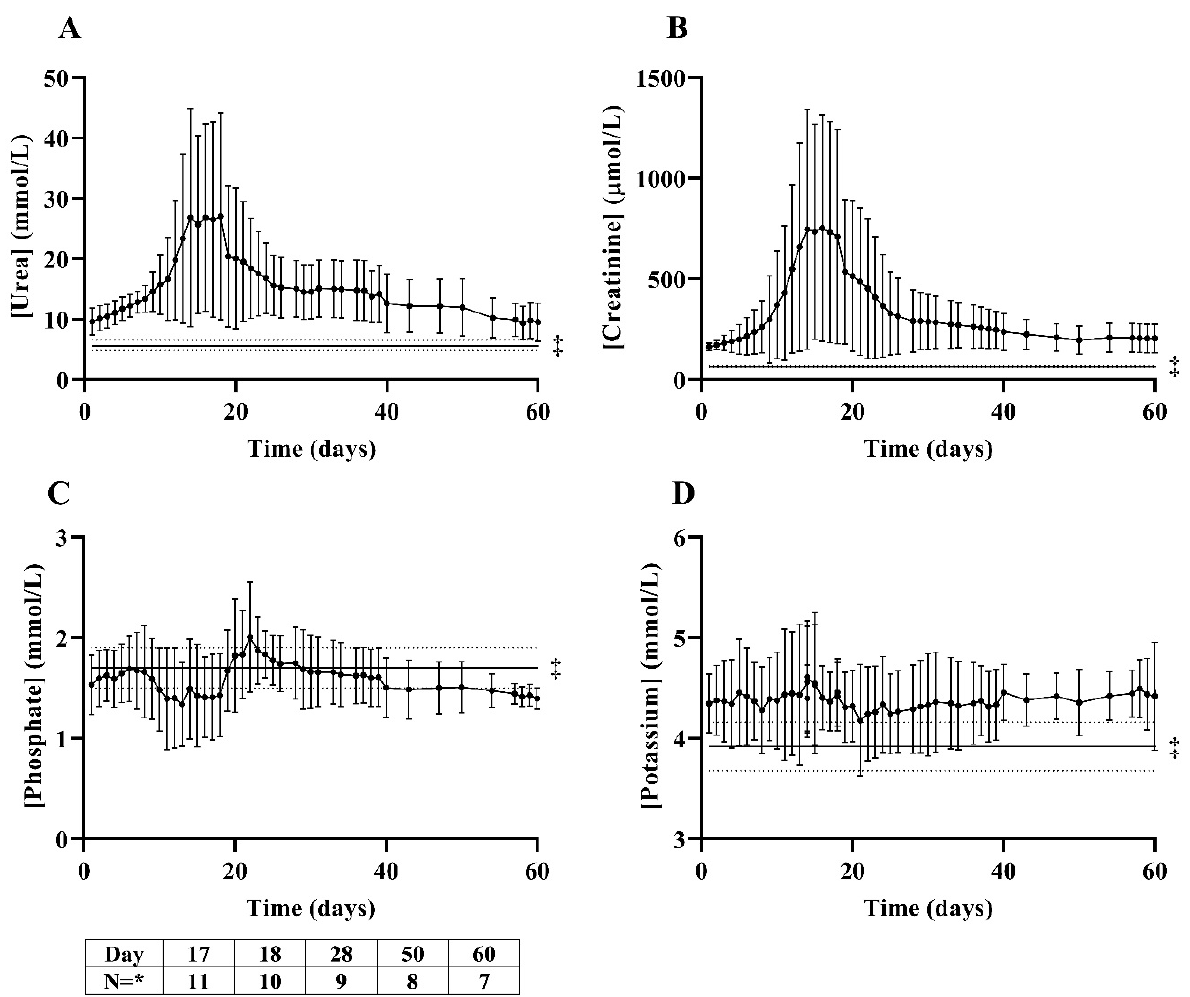
Figure 2. Mean ( ± SD) plasma concentrations of urea (mmol/L, ( A )), creatinine ( µ mol/L, ( B )), phosphate (mmol/L, ( C )) and potassium (mmol/L, ( D )) after administration of gentamicin 10 mg/kg twice daily for 7–10 days in goats ( n = 11 courses in n = 5 goats, 1–3 gentamicin courses per goat). Gentamicin was started at day 1. * Number of gentamicin courses per timepoint. ‡ Mean ( ± SD) pre-embolization plasma concentration.